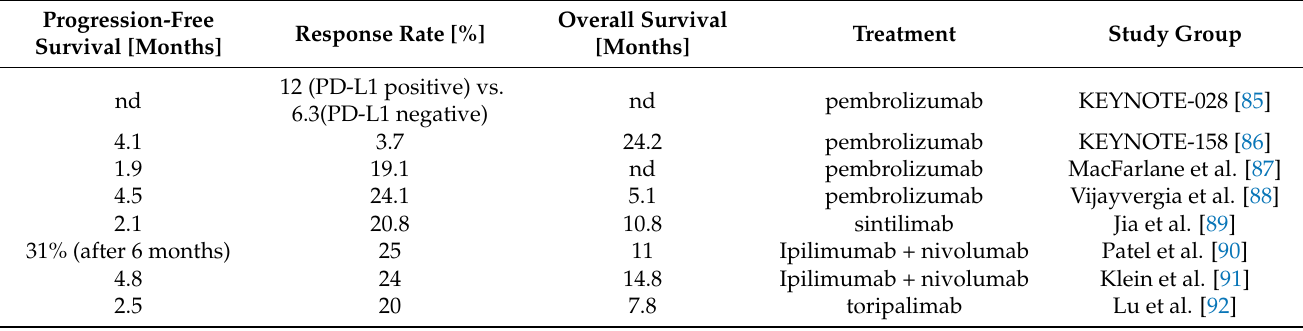
Table 1. Results of immunotherapy in GEP